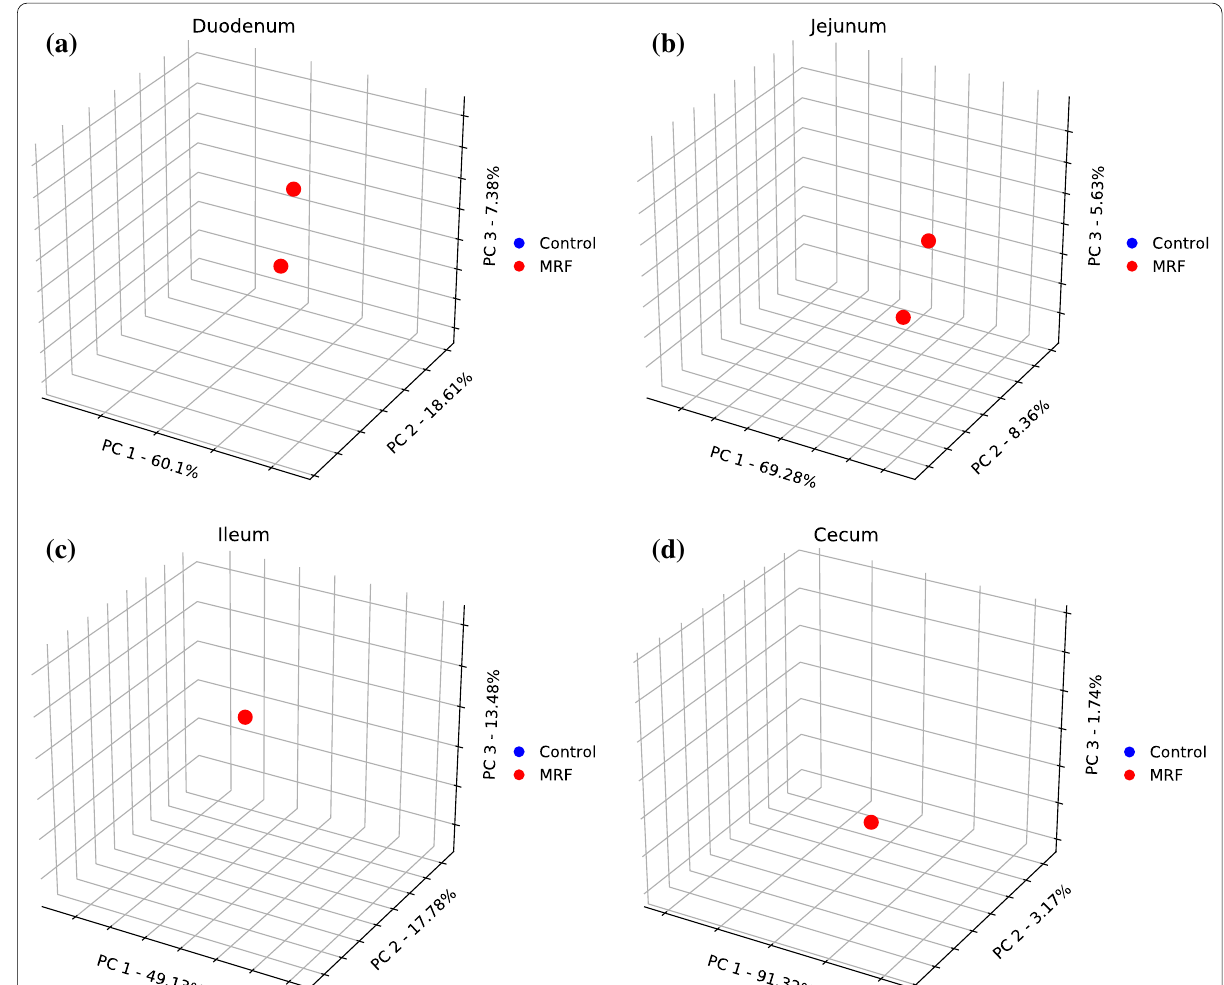
Fig. 2 a – d Species-level Bray–Curtis distance matrices (β-diversity) expressed as PCoA between control (red) and MRF-supplemented broilers (blue) at each anatomical